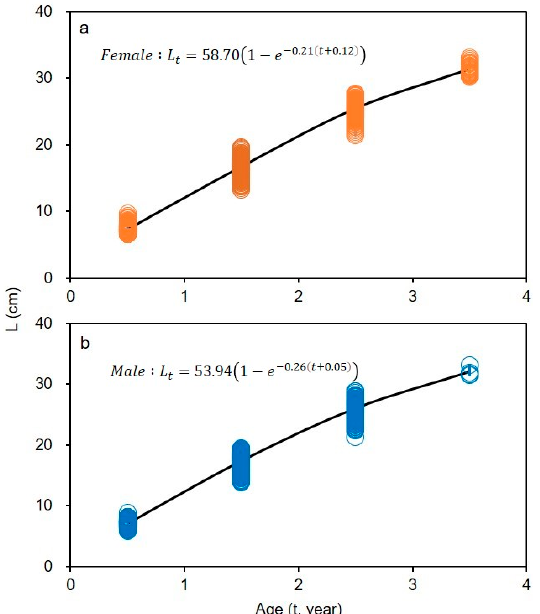
Figure 10. Theoretical von Bertalan ff y growth curves of disc width for ( a ) female and ( b ) male specimens of Okamejei kenojei collected from the West Sea of South Korea. Vertical bars represent standard deviations.